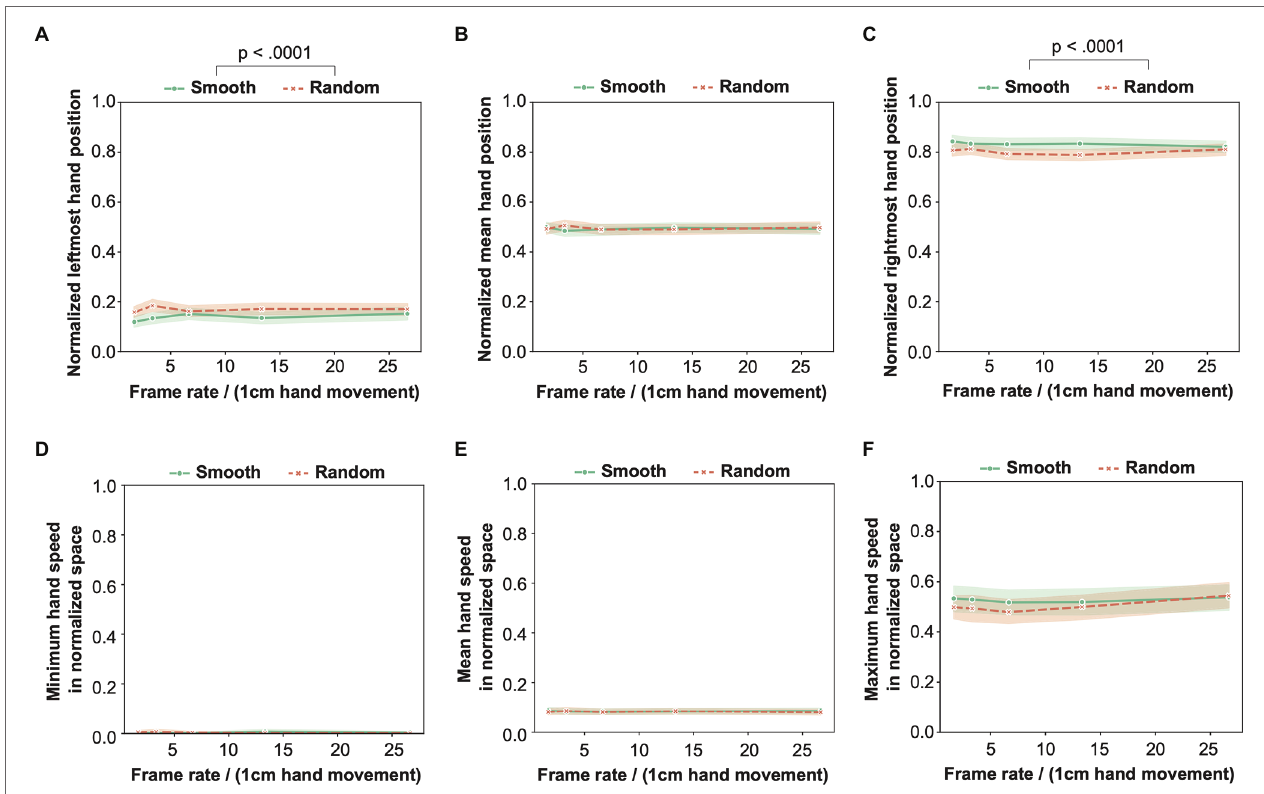
FIGURE 4 | The results of the analysis for the hand position and hand movement speed in normalized hand space. (A) Leftmost hand position, (B) Mean hand position, (C) Rightmost hand position, (D) Minimum hand speed, (E) Mean hand speed, and (F) Maximum hand speed. See text for the detail of these